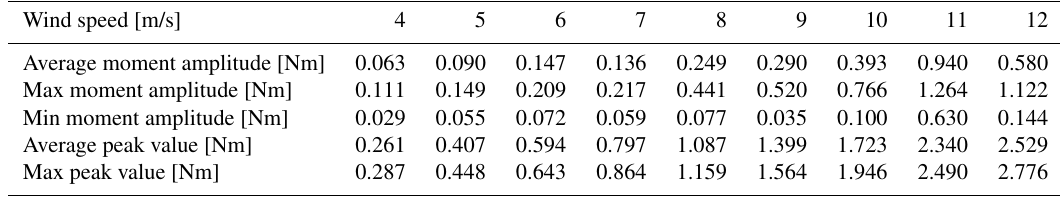
Table 4. Case C testing parameters of bending moments for wind speed range.